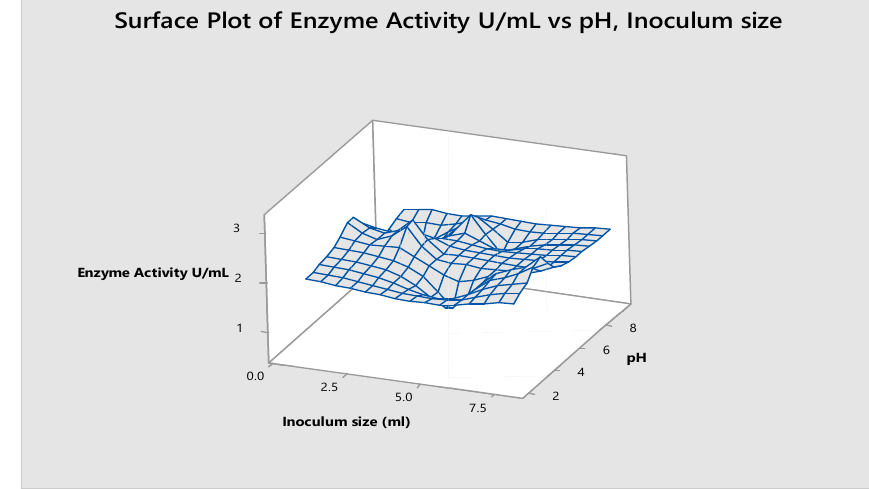
Figure 9. Surface plot of Enzyme Activity (U/mL) vs. pH and Inoculum Size.